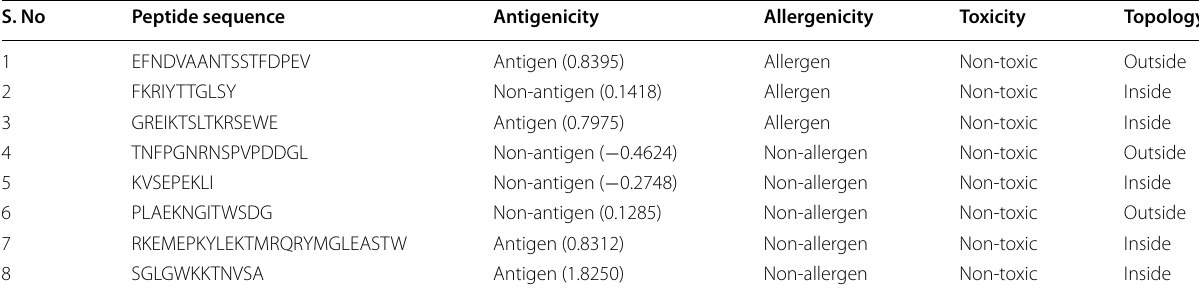
Table 1 B cell epitope antigenicity, allergenicity, toxicity, and topology S. No